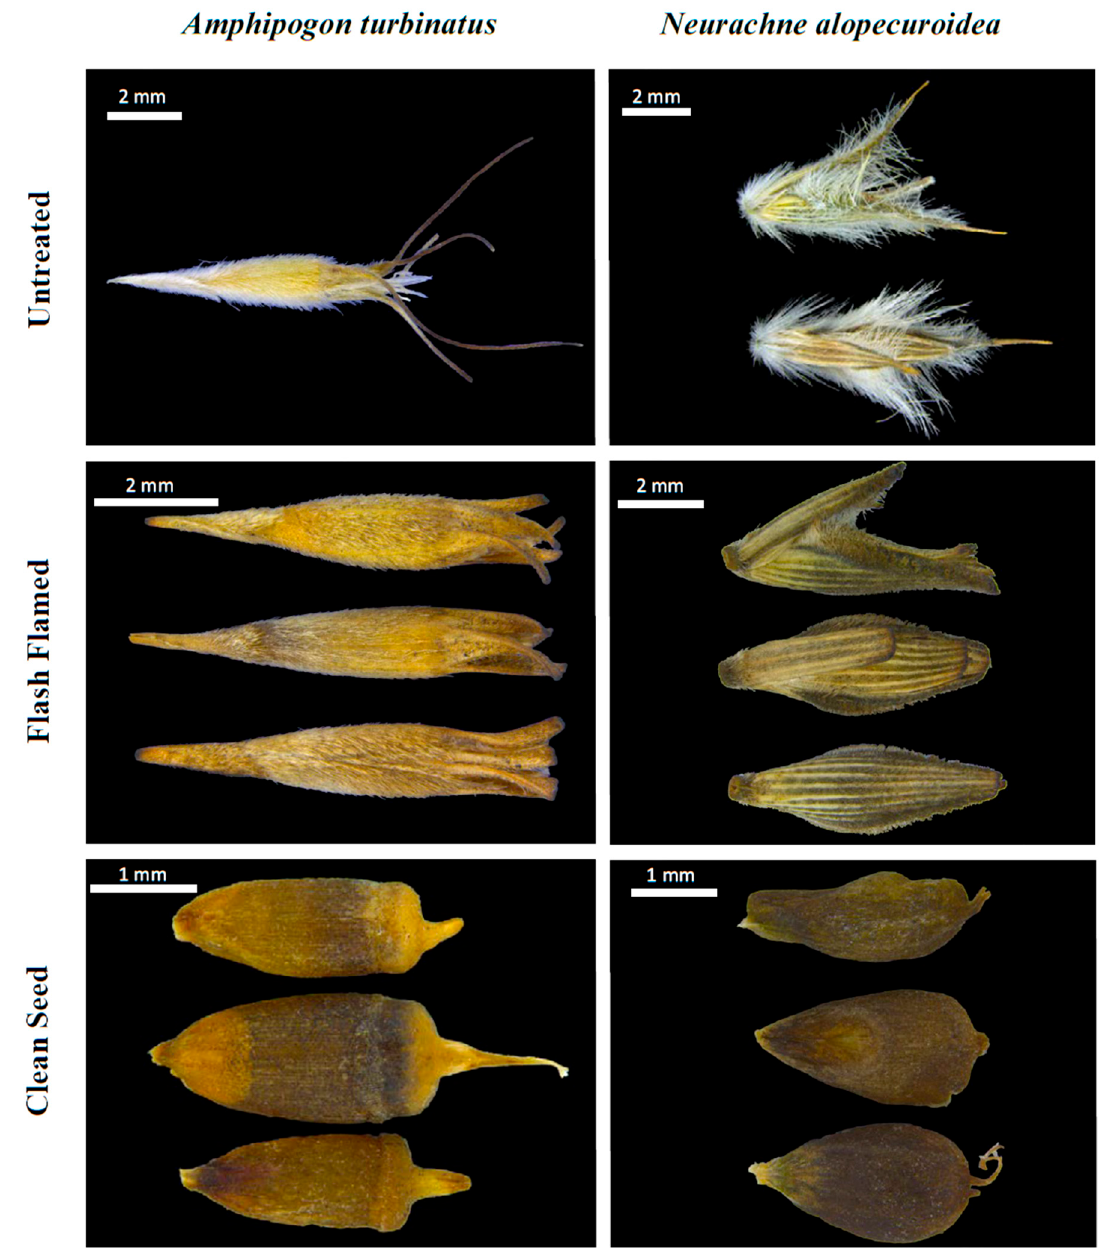
Figure 1. High resolution images of untreated florets (top row), flash flamed florets (middle row), and clean seeds (bottom row) of Amphipogon turbinatus (left column) and Neurachne alopecuroidea (right column).